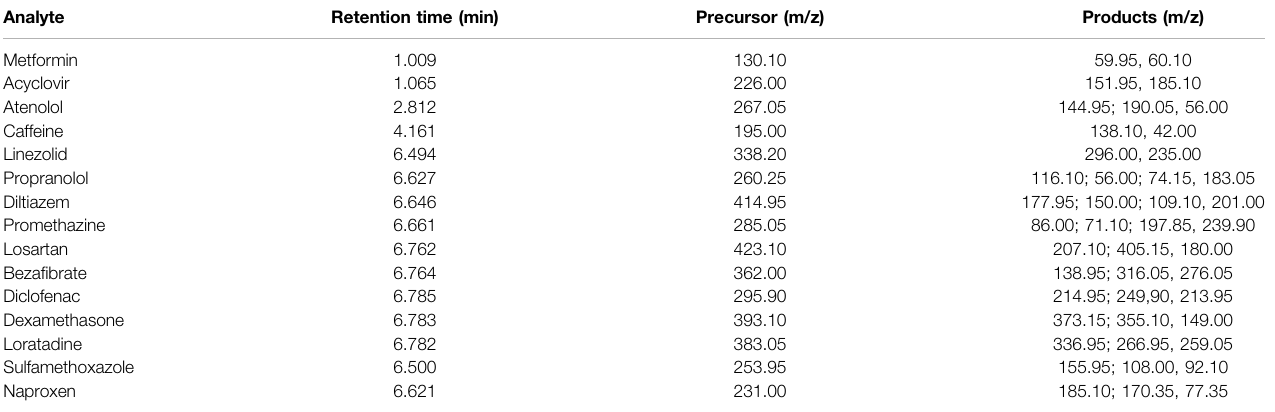
TABLE 3 | Mass/charge ratio (m/z) of precursor and products monitored in LC/MS in Multiple Reaction Monitoring (MRM) mode.